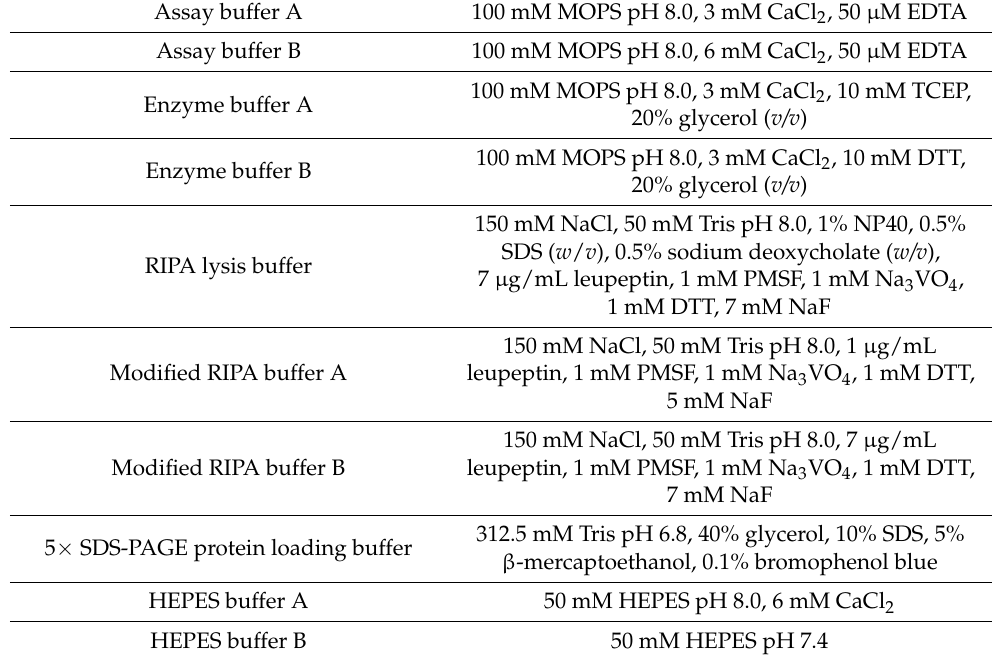
Table 4. Buffer names and their